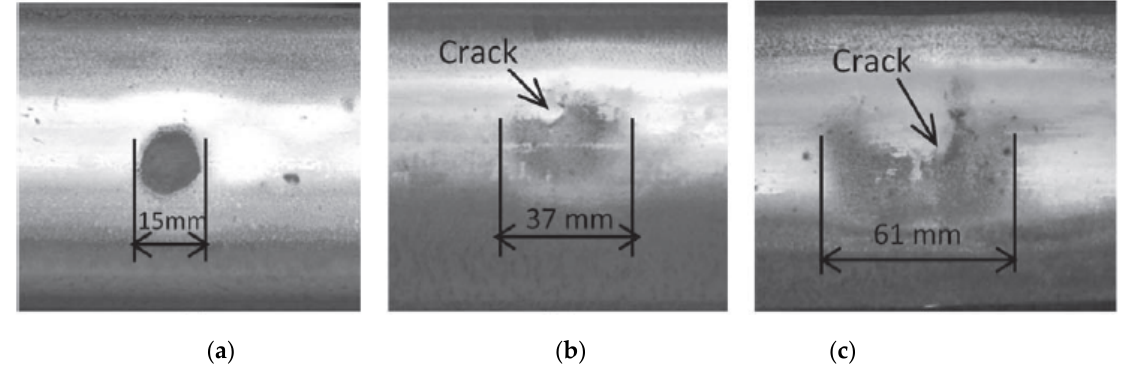
Figure 1. ( a ) Light squat. ( b ) Moderate squat. ( c ) Severe squat